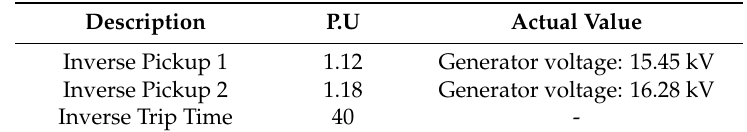
Table 4. V/Hz set values.